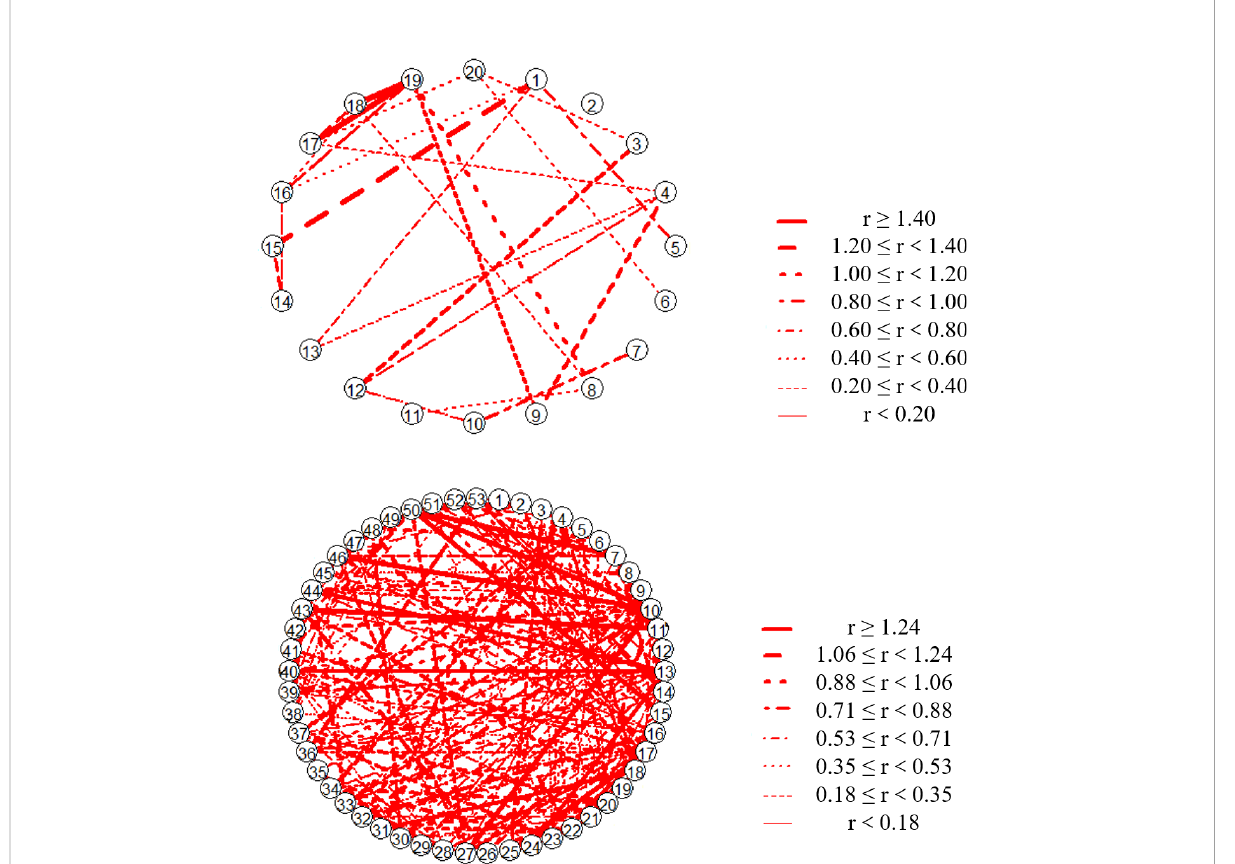
FIGURE 7 Coef fi cient of niche overlap among species on the O-ARs (below) and N-ARs (above) (only relationships with values greater than 0.5 are shown). Each serial number in network graphs represents a species (Table S2 and Table S3), and the type of line connecting the two serial numbers represents the range of the niche overlap